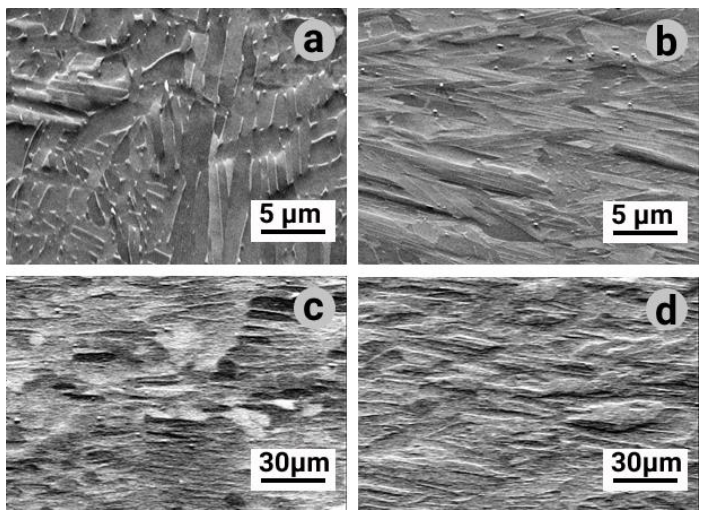
Figure 3. SEM micrographs of EBM manufactured Ti-6Al-4V samples with and without the HIP process: ( a ) S1, ( b ) S2, ( c ) S3, ( d ) S4.